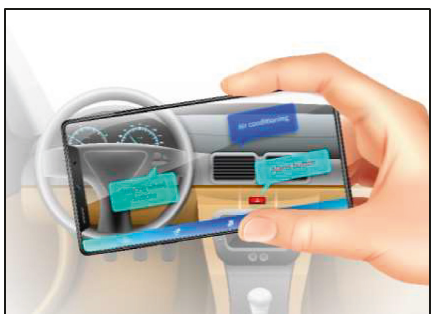
Figure 5: The AR technology can give more information on any real-world object, such as the different parts inside a car. This can be an innovative way for people learning to drive a car for the first time to understand the different parts. With the help of AR, people can also scan statues, monuments, paintings, and much more to receive more information about them